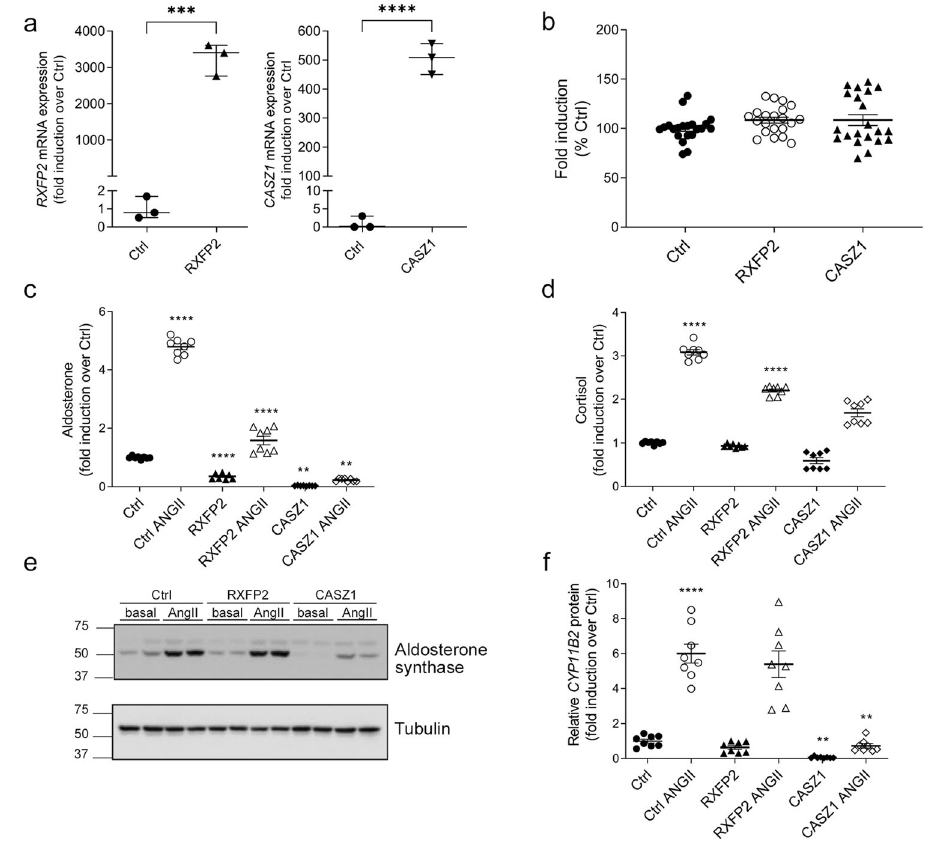
Fig. 4 | Effect of RXFP2 and CASZ1 overexpression in H295R-S2 cells. a RXFP2 andCASZ1mRNAexpressioninH295R-S2cellsstablytransfectedwithexpression vectors coding for pcDNA3 (Ctrl), RXFP2 (RXFP2), or CASZ1 (CASZ1). mRNA expression is normalized against the geometric mean of three housekeeping genes. RXFP2 vs Ctrl, *** p =0.0002; CASZ1 vs Ctrl **** p <0.0001; unpaired t test, two-sided. b Effect of RXFP2 and CASZ1 overexpression in stably transfected H295R-S2 cells on cell proliferation. Cells were seeded in 96-well plates at a densityof5000cells/wellandgrownfor4days.Basalandstimulatedaldosterone ( c ) and cortisol ( d ) production by H295R-S2 cells stably expressing RXFP2 or CASZ1. H295R-S2 cells were serum deprived for 24h and then incubated for another24hwithfreshserumdeprivedmediuminabsence(basal)orpresenceof 10nM AngII. Aldosterone and cortisol levels are indicated as fold induction over mock-transfected cells in basal conditions. Aldosterone: Ctrl+AngII vs Ctrl **** p <0.0001; RXFP2 vs Ctrl **** p <0.0001; CASZ1 vs Ctrl ** p =0.0013; RXFP2+